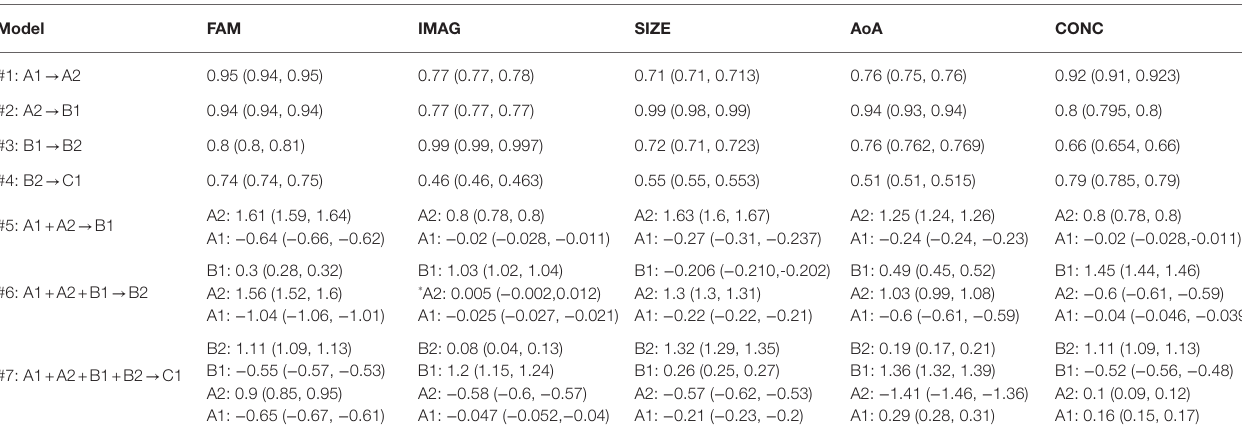
TABLE 3 | Bayesian regression results on the five EFCAMDAT2 sub-corpora ( N = 7883). Model FAM